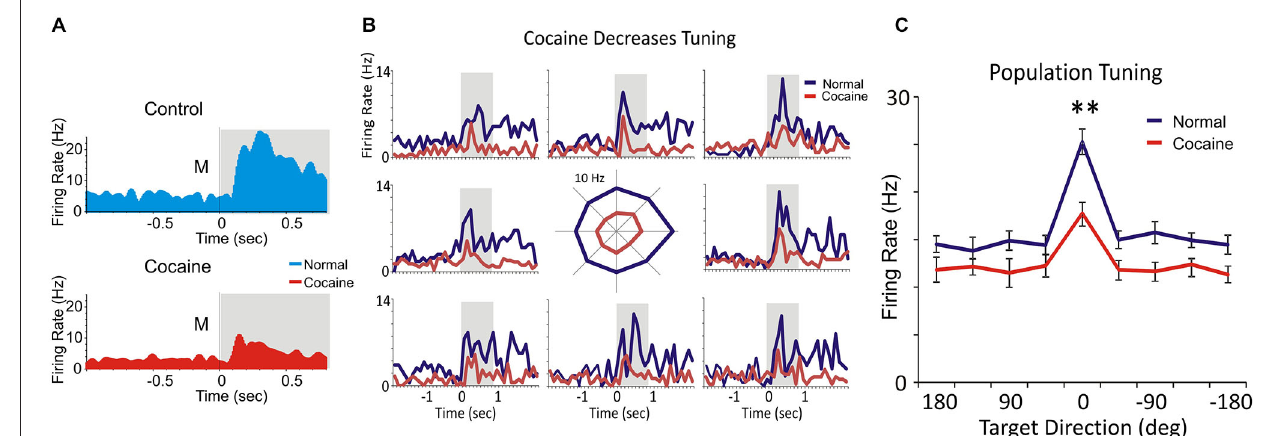
cursor into each of the 8 screen image positions from the screen center summed over all trials in a single session. The spatial “bias” for minicolumn firing (layers 2/3 and 5 cells) is indicated by an increased firing rate for target selection in one position (i.e., left 180 ◦ position) vs. all others during the session. (C) The comparison of spatial tuning across all PFC neurons indicates decreased spatial preference for minicolumnar firing (layers 2/3 and 5 cells) after cocaine administration in the same session. ** p < 0.001,